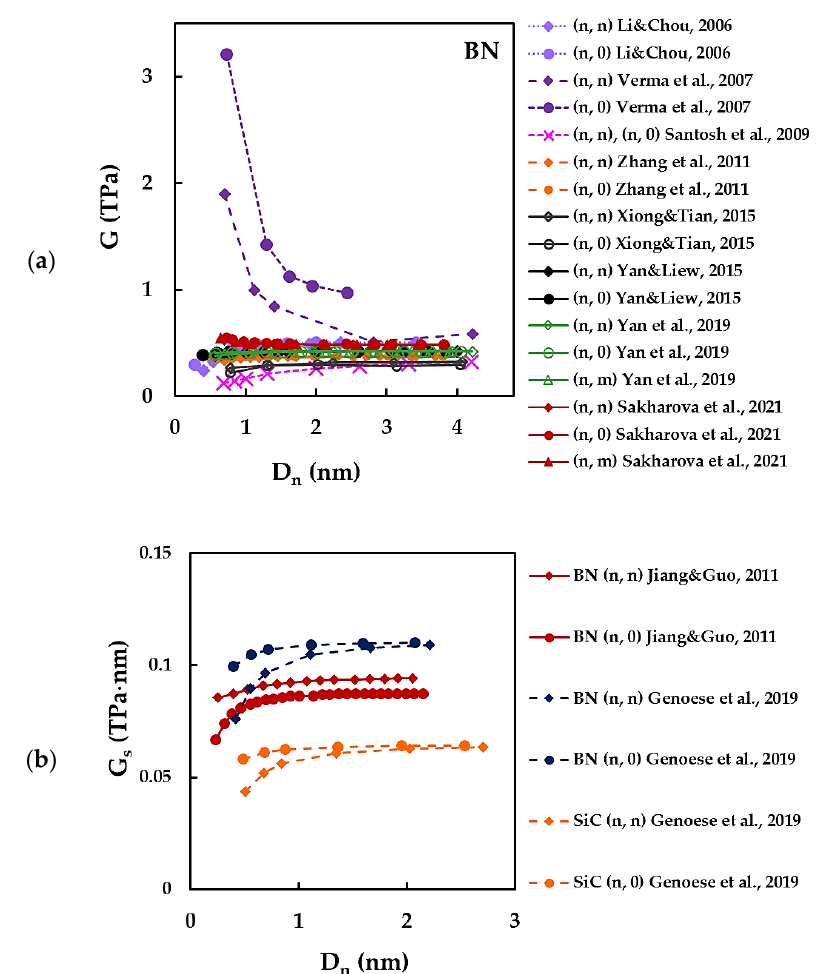
Figure 6. ( a ) Shear modulus, G, for BNNTs [34,36,50,55,59,61,70,71] and ( b ) surface shear modulus, G s , for BNNTs [33,41] and SiCNTs [41], as a function of the nanotube diameter, D n